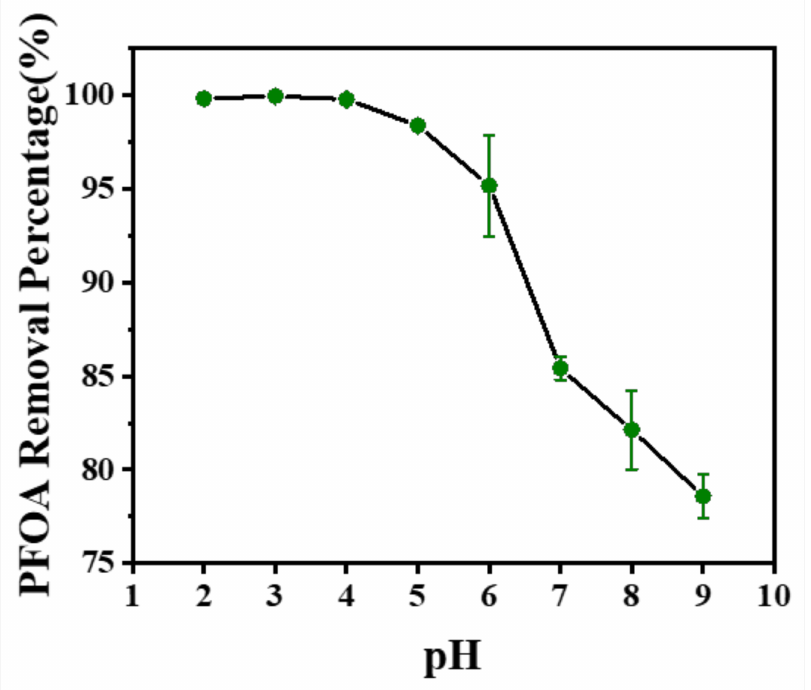
Figure 4. The effect of pH on the removal of PFOA at initial concentrations of 1 mg L − 1 , an adsorbent dose of 200 mg L − 1 , and contact time of 24 h. Vertical error bars represent standard deviation from triplicated